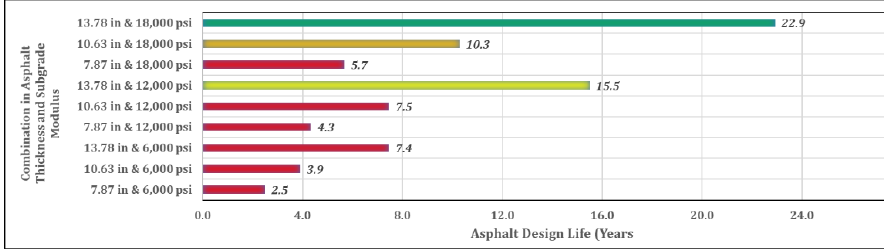
Figure 32: Influence of subgrade modulus and asphalt thickness on asphalt service life in asphaltic overlayment track.